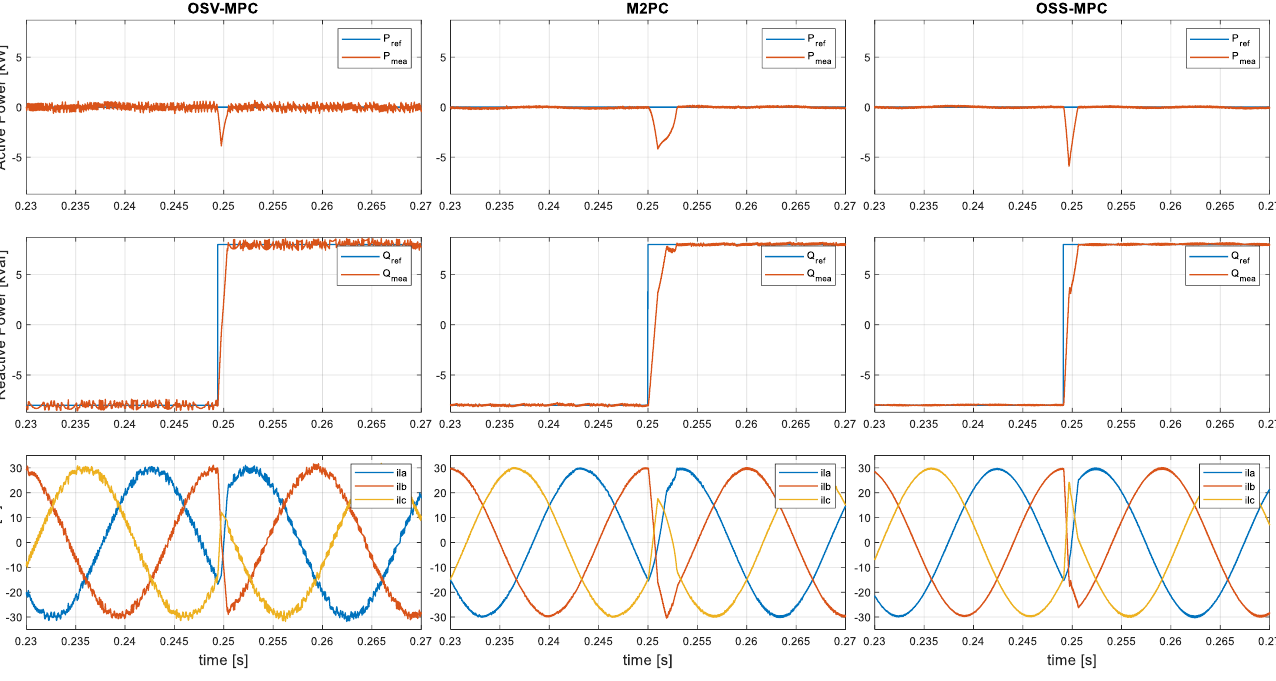
Figure 21. Transient response for active power step 𝑄 ∗ = −8 kVAr to 𝑄 ∗ = +8 kVAr for each FCS-MPC technique. Table 5. Transient experimental results.